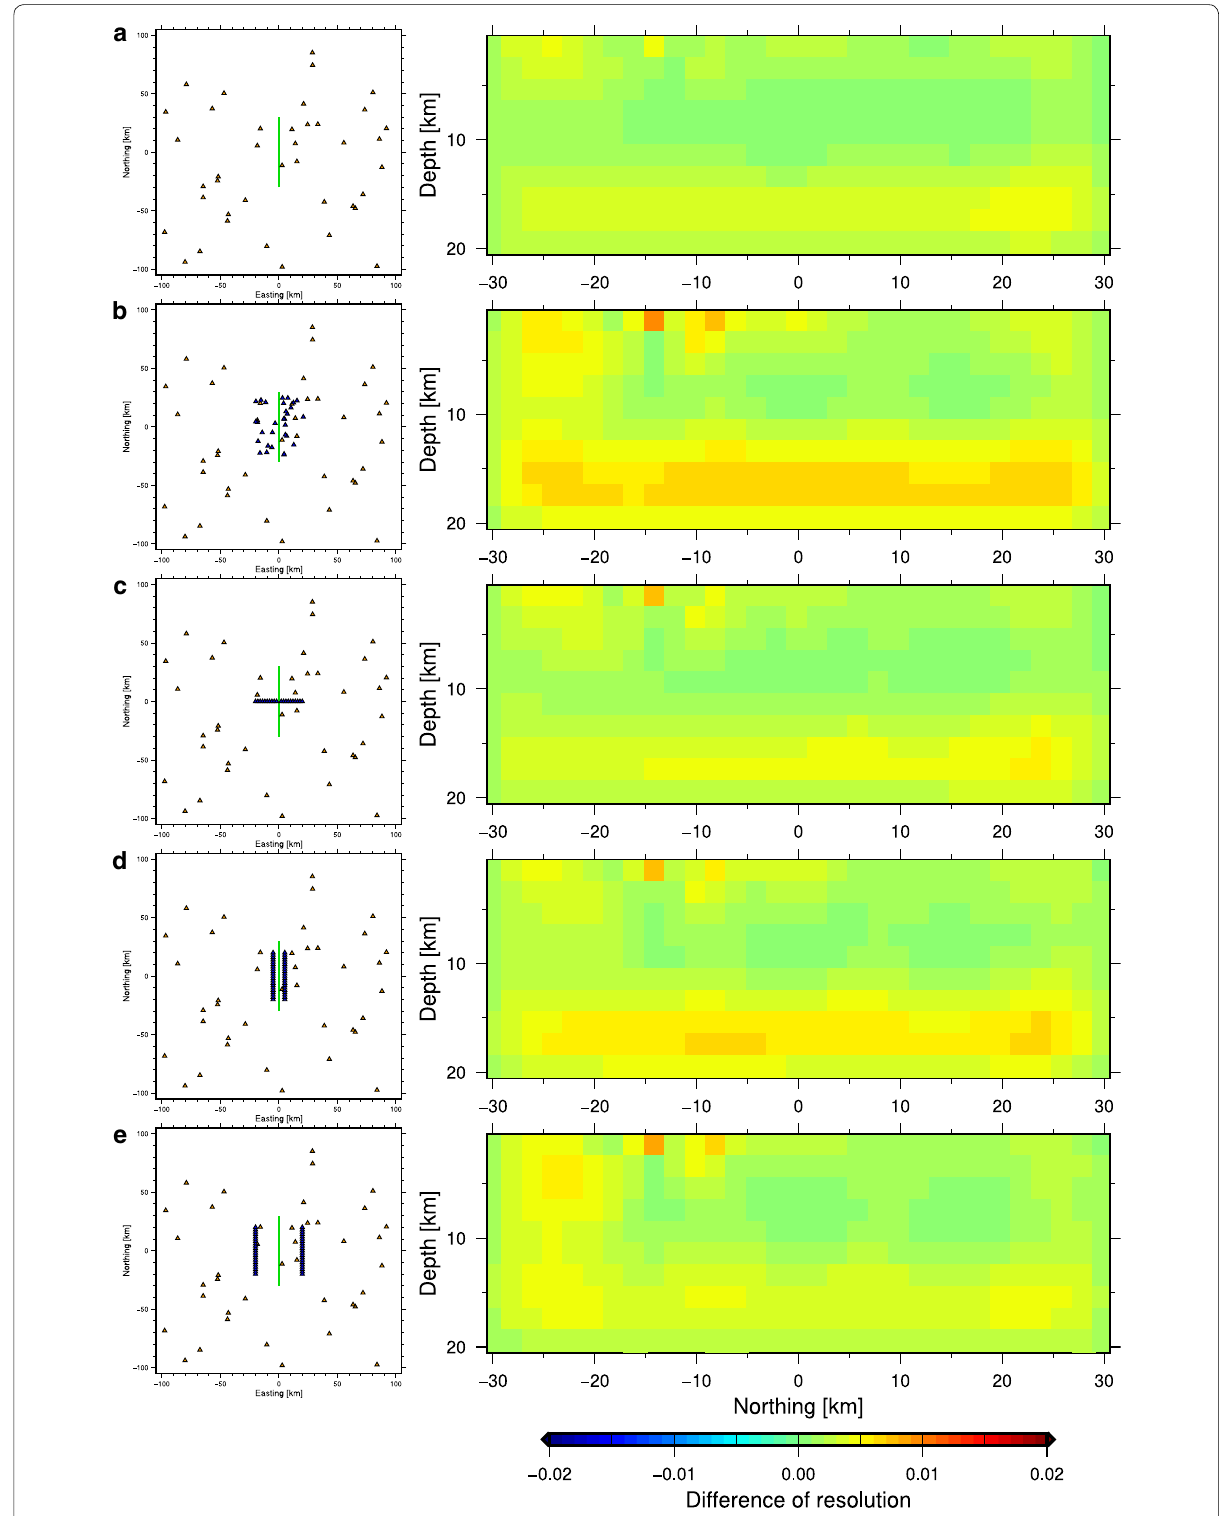
Fig. 5 Improvement of the spatial resolution assuming various postseismic site distributions for the strike–slip case. Left panels shows synthetic geodetic observational sites; yellow triangles indicate the sites in both the co- and the post-seismic periods, while blue triangles indicates the sites only in the postseismic period. Right panels show difference of the spatial resolution on the coseismic slip same as with Fig.